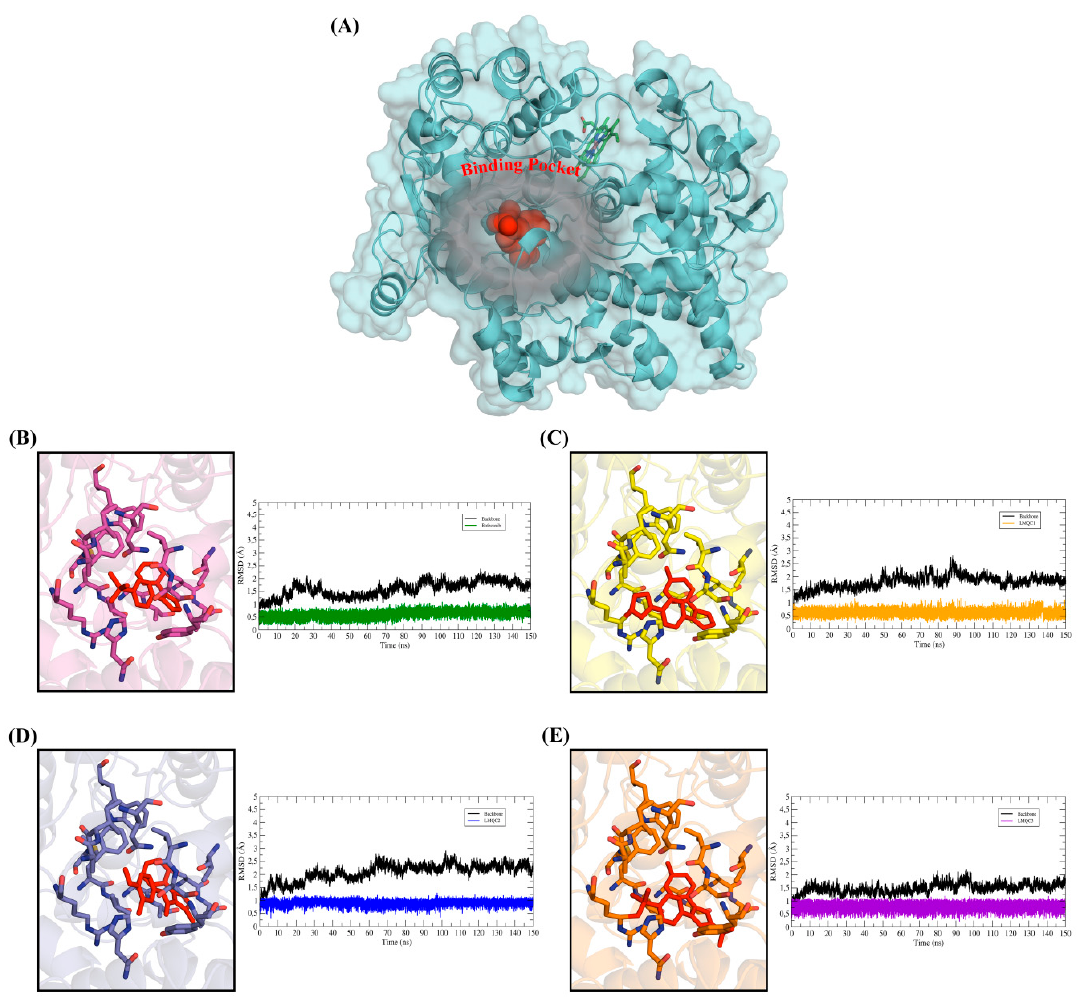
(MD) simulations. RMSD graphs for 150 ns of MD simulations. In all the Figures, the RMSD plot of the h COX-2 backbone was represented by the color black, while the RMSD of the ligands was represented in di ff erent colors. ( A ) General view of the protein structure with emphasis on the binding pocket occupied by the ligands. The protein was represented in cyan color and ligand protein was represented in spheres (red color). ( B ) RMSDs of h COX-2-rofecoxib- system, ( C ) RMSDs of h COX-2-LMQC72 system, ( D ) RMSDs of h COX-2- LMQC36 system, ( E ) RMSDs of h COX-2- LMQC50 system. Ligands and residues were represented in